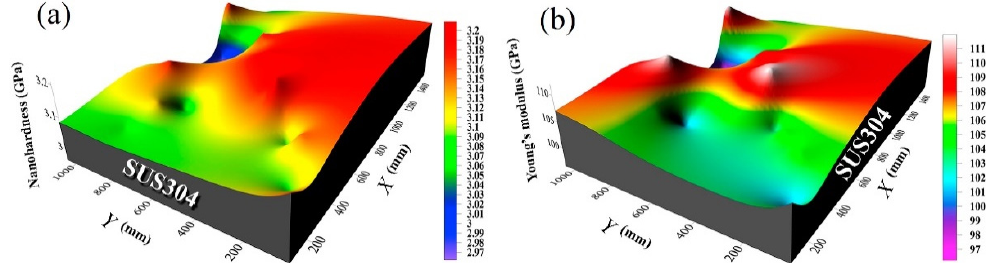
Figure 9. ( a ) The nanohardness and ( b ) Young’s modulus results are shown in isometric projections. Reprinted with permission from [63] Copyright 2021 Elsevier .